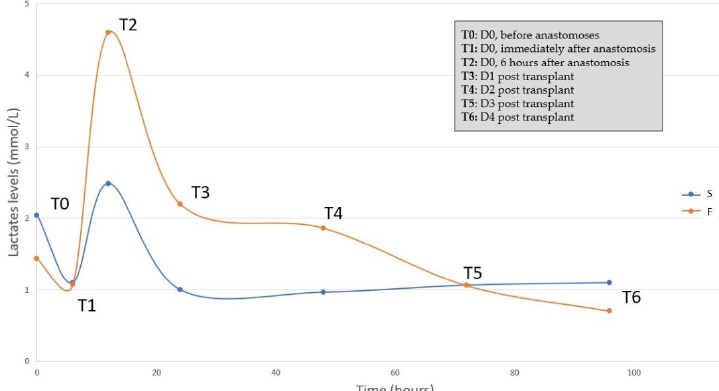
Figure 5. Lactate levels in success and failure autotransplant groups). S = success, F = failure. Table 4. Lactate levels at T1 (directly after anastomoses) and T2 (6 h after reperfusion). S = success, F = failure. Rank of Ewes